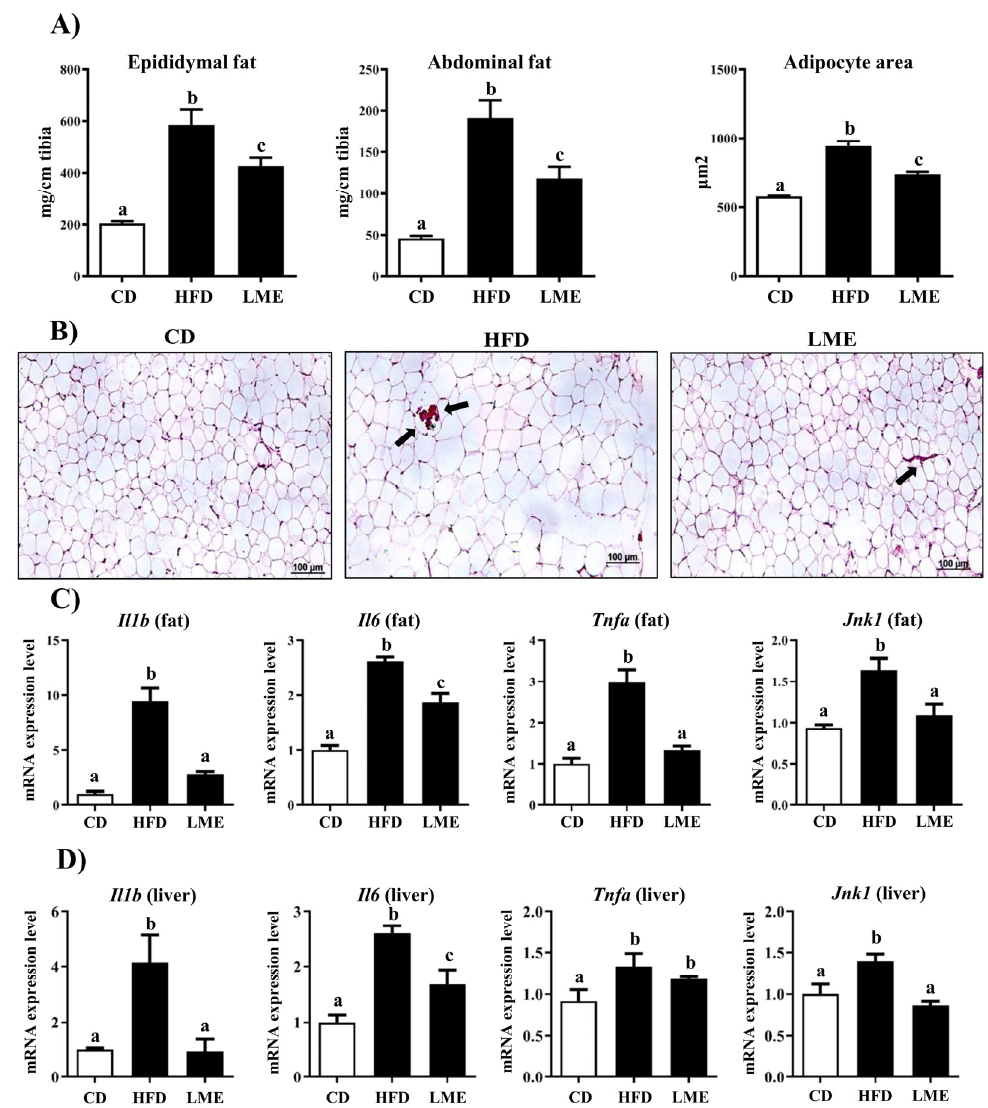
Figure 7. Effects of LME supplementation on ( A ) fat deposits weights; ( B ) epididymal adipose tissue, analyzed by hematoxylin and eosin staining (black arrows show mononuclear inflammatory aggregation); and ( C , D ) gene expression of IL-1 β , Il-6 , Tnf- α , and Jnk1 in fat and liver. Data are expressed as means ± SEM ( n = 8). Groups with different letters statistically differ ( p < 0.05).